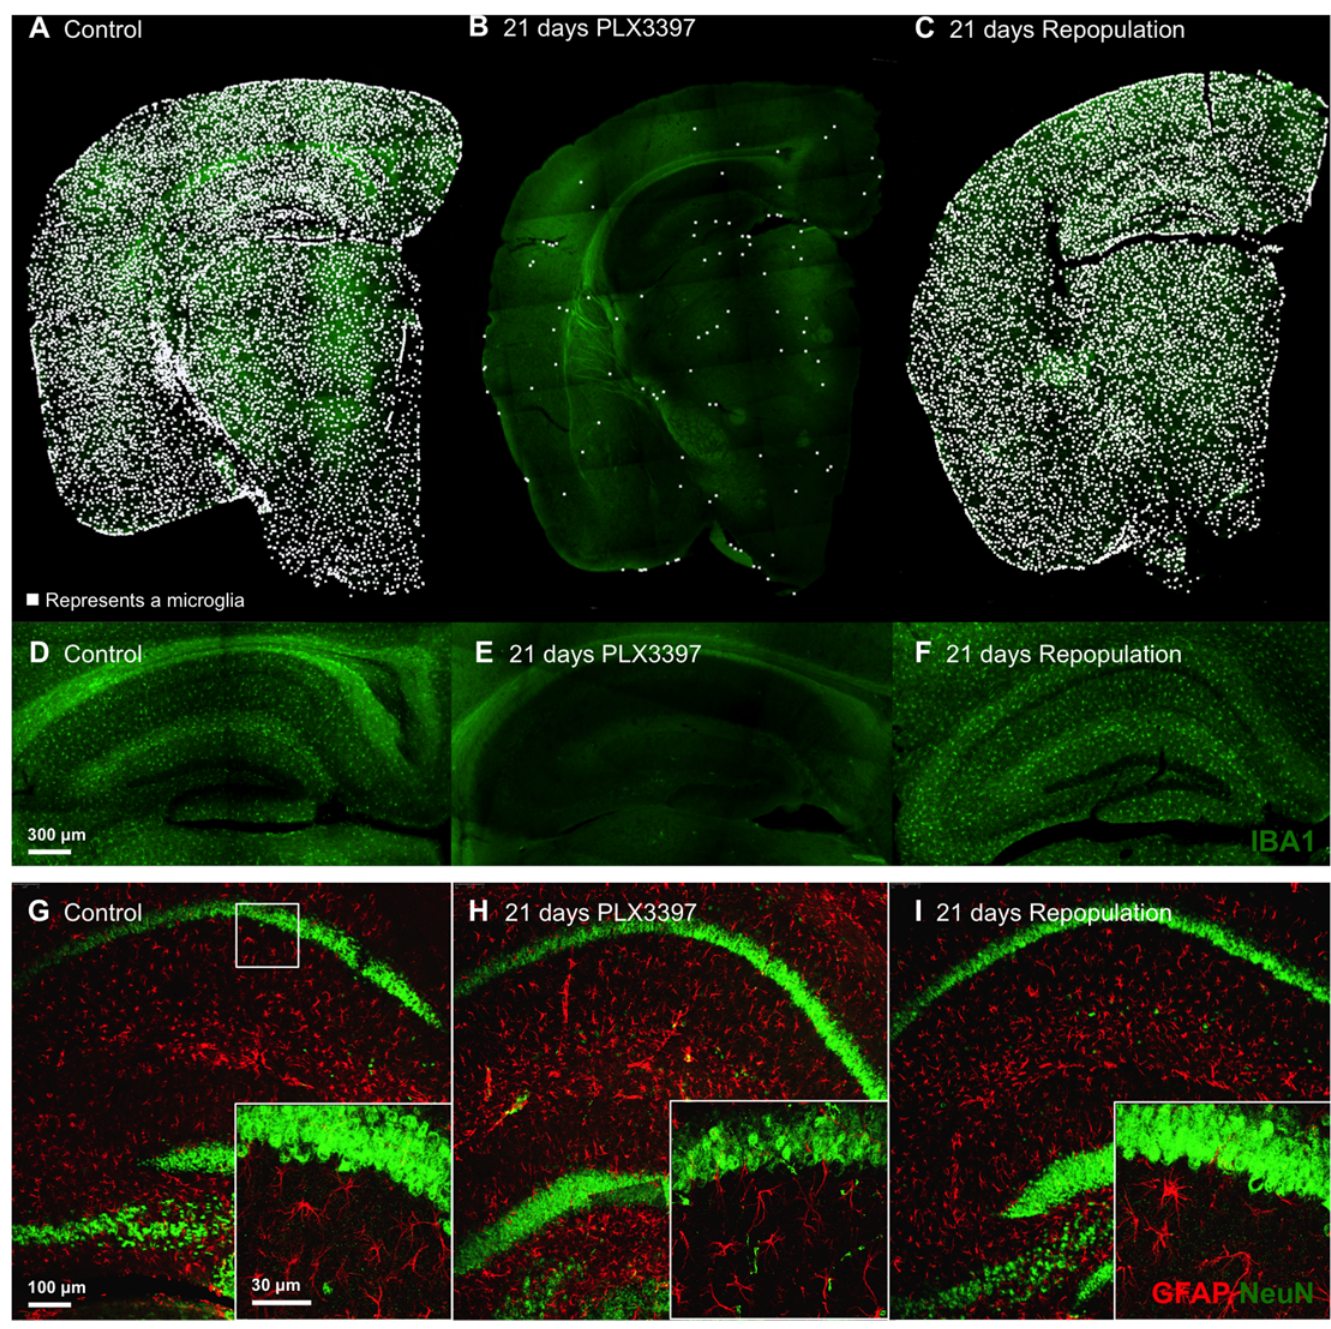
Fig 1. Elimination of Microglia in the Adult CNS Using CSF1R/c-Kit Inhibition, Followed by Repopulation with New Cells. A, B) Two month-old wild- type mice were placed on either control (n = 10) or inhibitor diet (PLX3397, provided at 290 mg/kg chow; n = 14) for 21 d, causing the elimination of approximately 99% of microglia brain-wide. A subset of mice were sacrificed to confirm microglial elimination and are shown in (B) (n = 4). C) For the remaining microglia eliminated mice (n = 10), the inhibitor was removed, allowing new microglia to repopulate the entire CNS during a 21d recovery period. Half brain stitches are shown and each microglia is represented with a white dot. D – F) Images of the hippocampal region for each treatment are shown, with IBA1 staining in green. G – I) 10x and 63x z-stack images of the CA1 hippocampal region for each treatment are shown, with NeuN staining in green and GFAP staining in